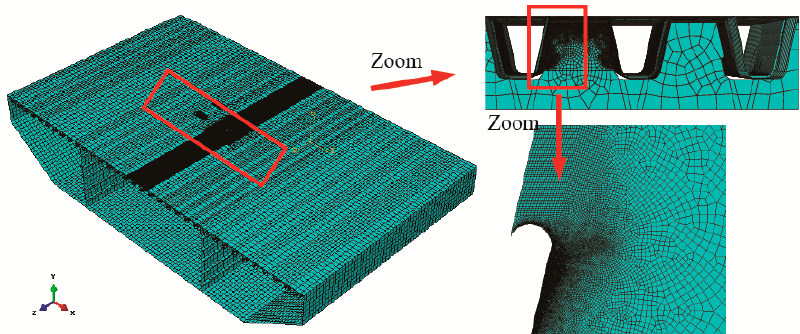
Figure 5. Finite element model of steel box girder.